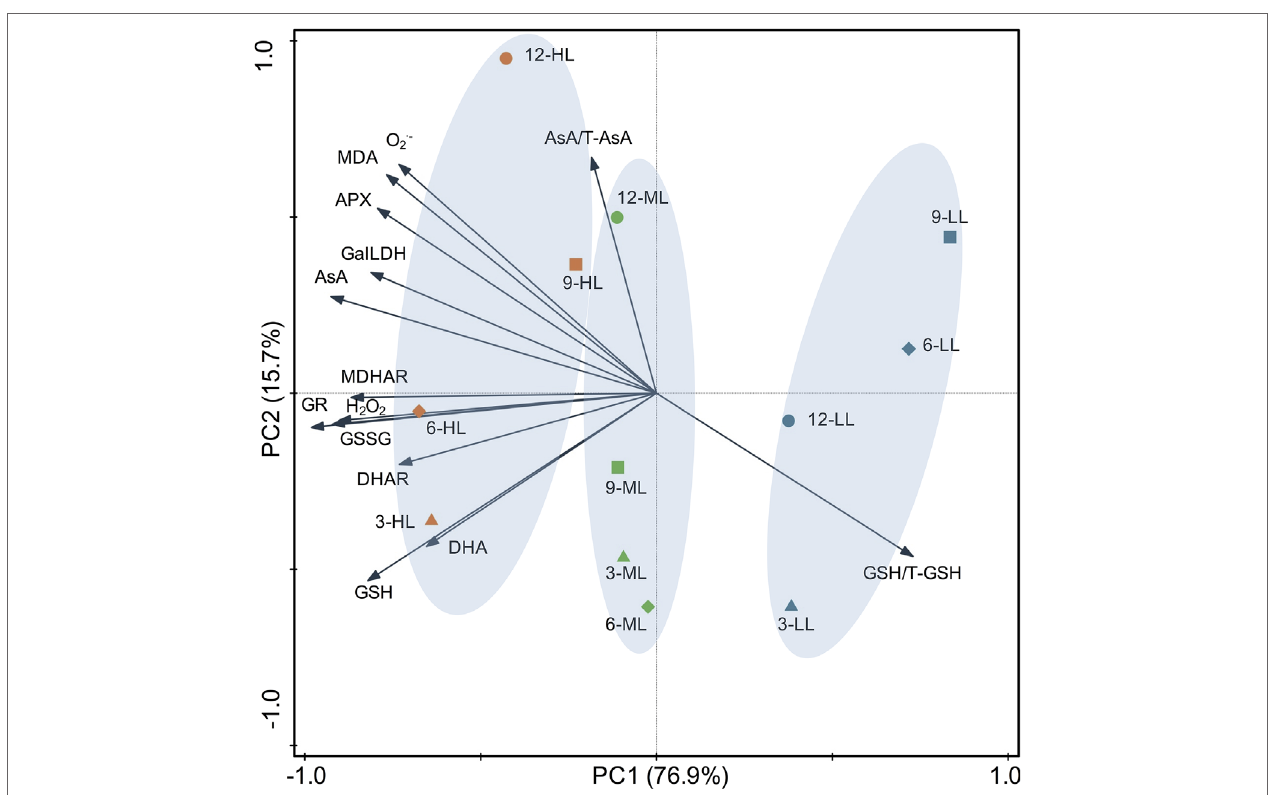
FIgURe 7 | Principal component analysis of physiological parameters in lettuce leaves under continuous light of different intensities (yellow symbol-HL, 300 μmol·m −2 ·s −1 ; green symbol-ML, 200 μmol·m −2 ·s −1 ; blue symbol-LL, 100 μmol·m −2 ·s −1 ) at different days ( △ –day 3; ◇ –day 6, □ –day 9, ○ –day 12). Biplot of the first two principal components (PC1,2) of the measured network topological properties. AsA, ascorbate; APX, ascorbate peroxidase; DHA, dehydroascorbate; DHAR dehydroascorbate reductase; GalLDH, L-galactono-1,4-lactone dehydrogenase; GR, glutathione reductase; GSH, glutathione; GSSG, oxidized glutathione; MDHA, monodehydroascorbate; MDHAR, monodehydroascorbate reductase; T-AsA, total ascorbate; T-GSH, total